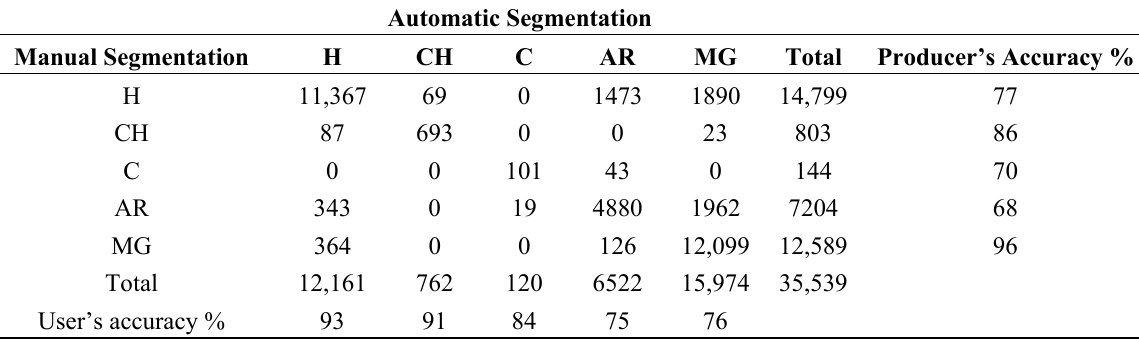
Table 5. Error matrix detailing FWF echo counts as derived from the integrated segmentation approach.